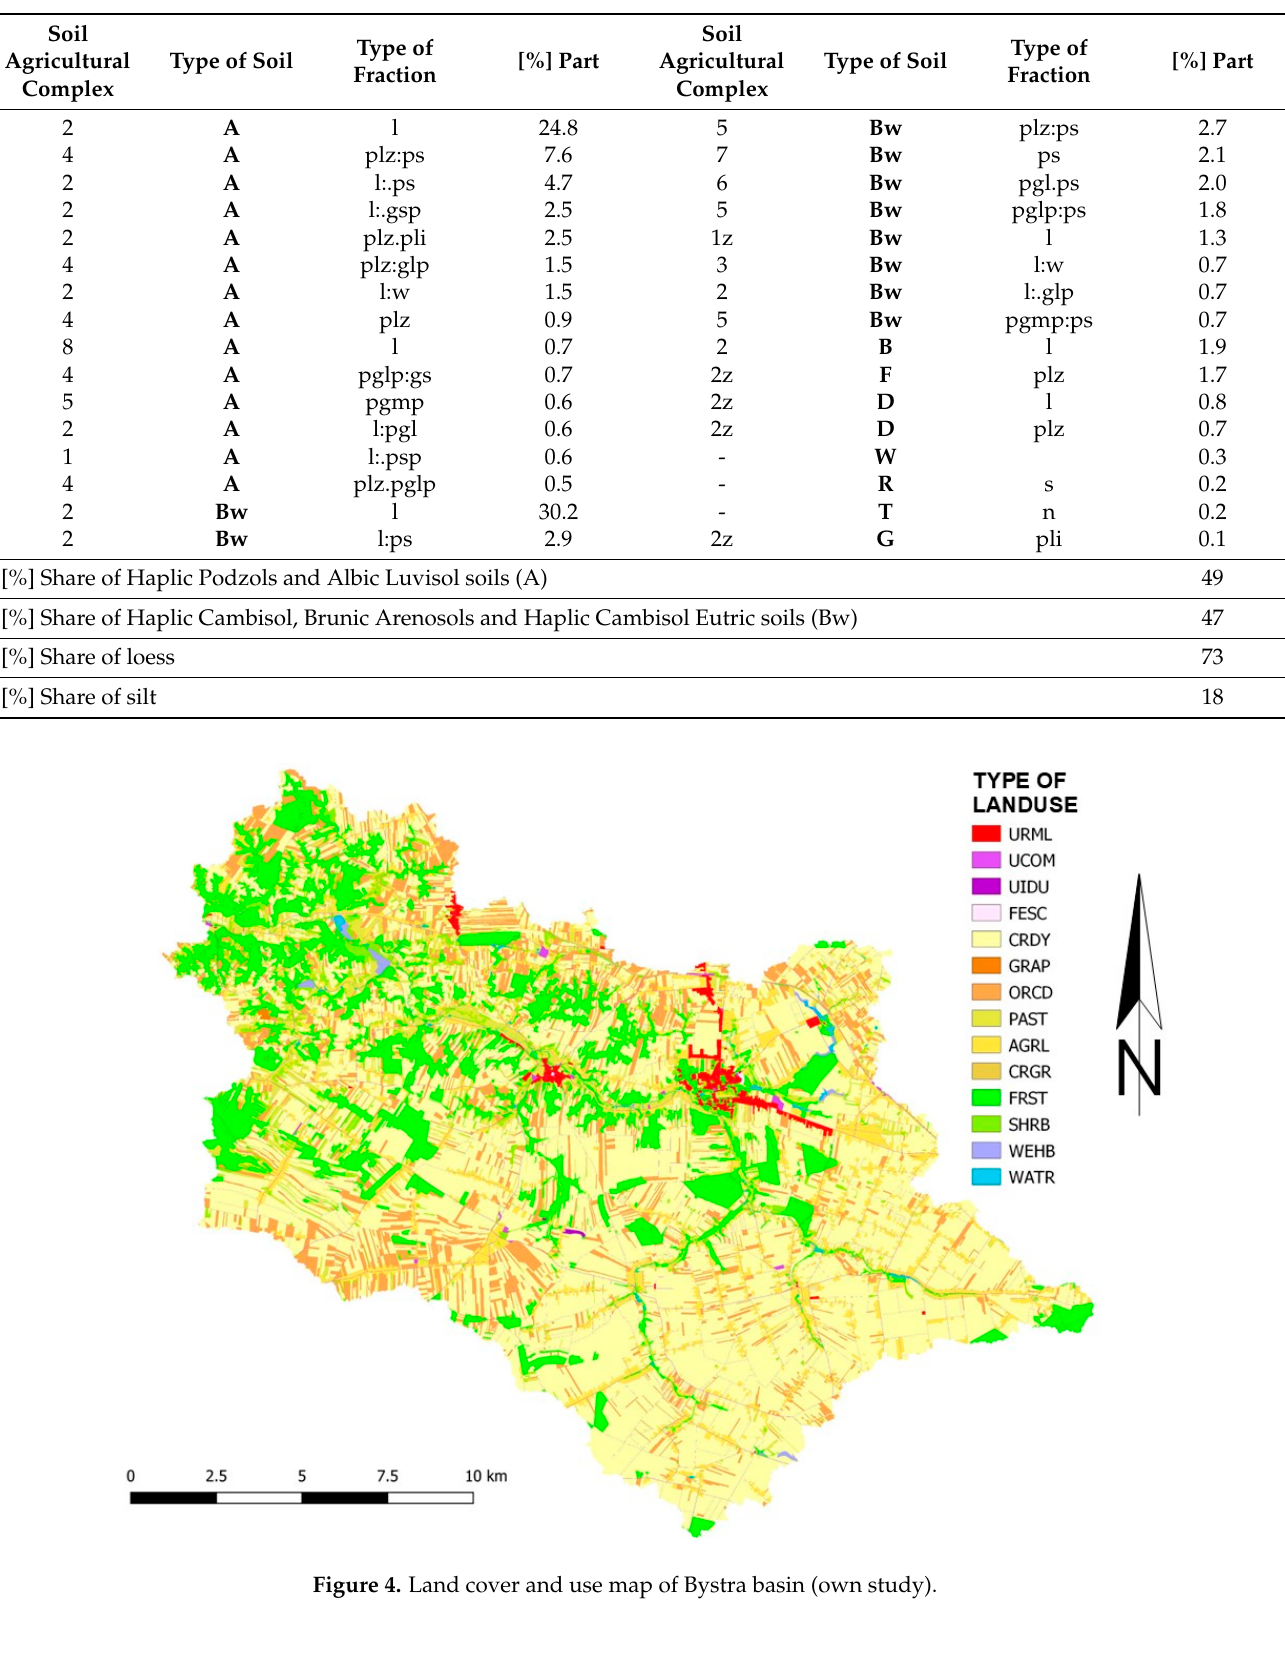
Table 1. Division into soil types and species and the percentage share of soils in the Bystra basin gener-ated in the QSWAT interface (own study).